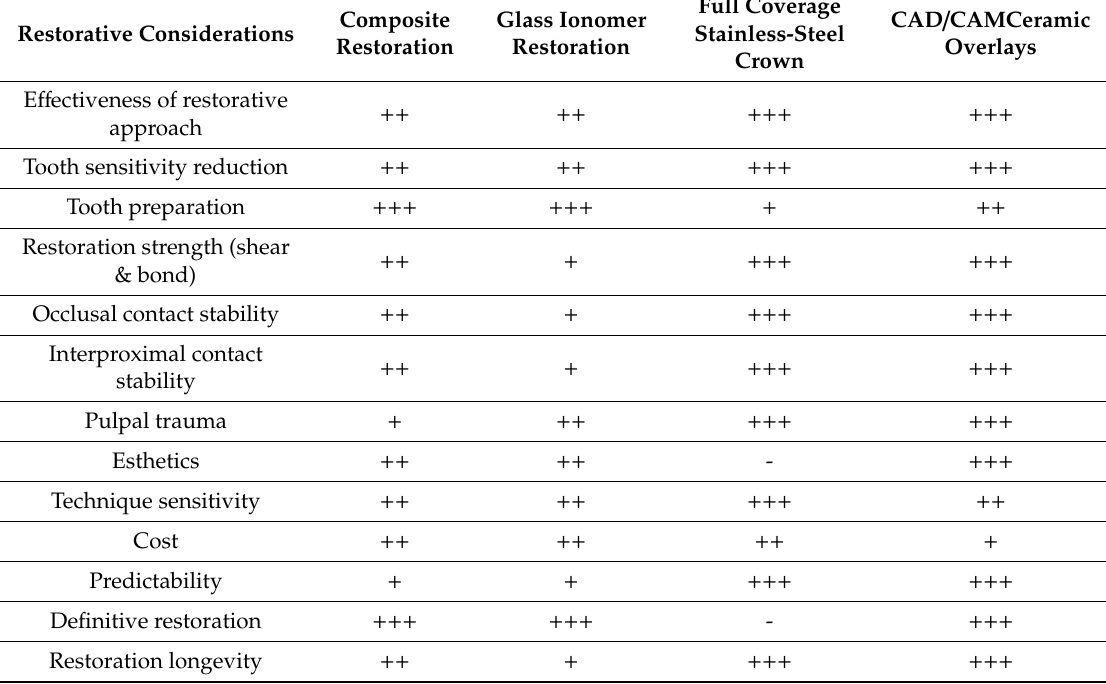
Table 1. Decision-making considerations when dealing with the restorative options for molar incisor hypomineralization (MIH) teeth in children. Restorative Considerations